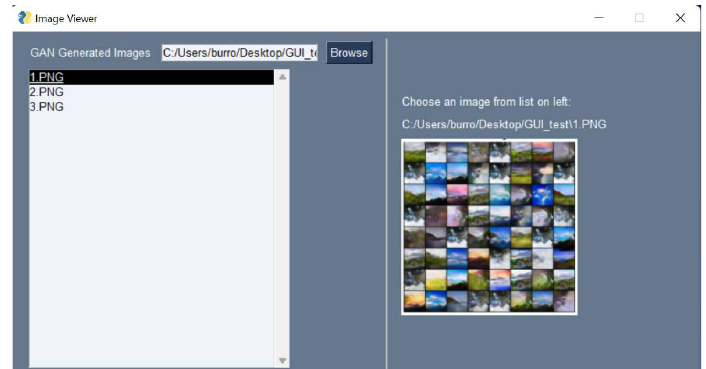
Figure 32. Graphical User